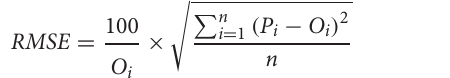
isotopic composition in M-rf and M-irr, and assuming that the POC 50 − 2,000 fraction represented the fast-cycling pool